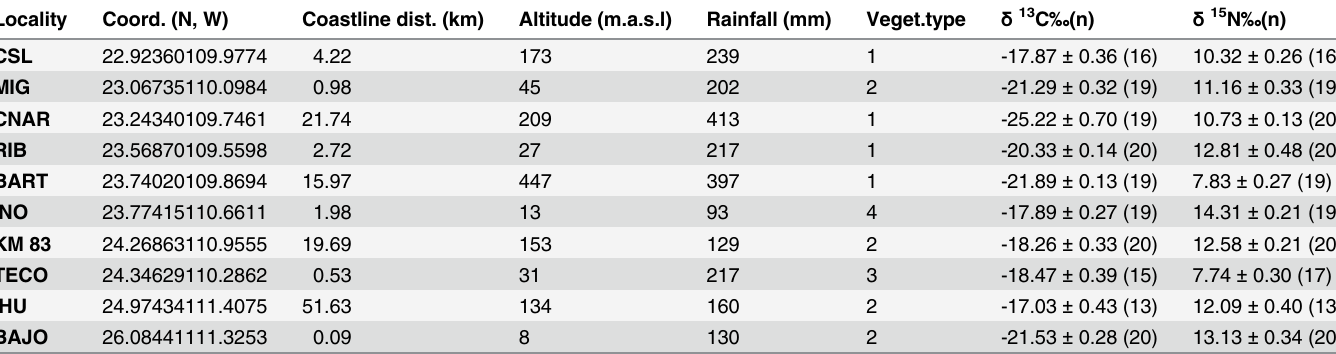
Sample sizes (n) and levels of δ 13 C and δ 15 N (mean + SE) correspond to lizard tail tips for each locality. Shortest distance to the coastline and average altitude were obtained from a GIS of the area, average annual rainfall was estimated from WORLDCLIM Ver. 1.2 (http://www.worldclim.org) and scrubs; 4, fog desert shrub (mostly Cactaceae, but with humidity from the sea and